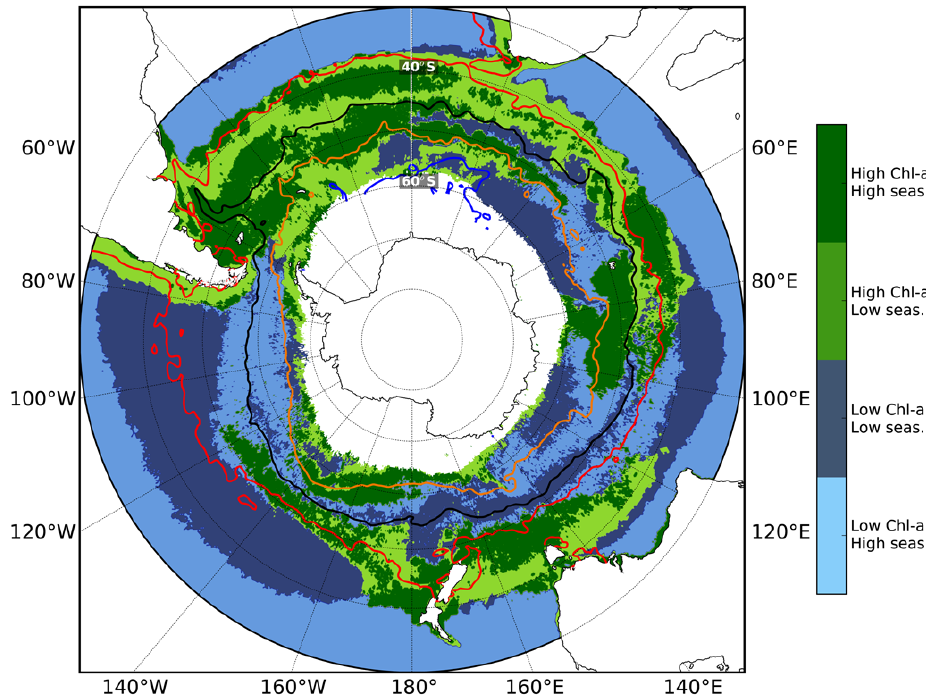
Fig. 9. A schematic summarising the response of phytoplankton biomass to the underlying physics of the different seasonal regimes. Regions in blue represent regions of low ( < 0.25mgm − 3 ) chlorophyll concentration with either high seasonal cycle reproducibility ( R 2 > 0 . 4) (Region A, light blue) or low seasonal cycle reproducibility ( R 2 < 0 . 4) (Region B, dark blue). Regions in green represent regions of high chlorophyll concentration ( > 0.25mgm − 3 ) with either high seasonal cycle reproducibility (Region C, dark green) or low seasonal cycle reproducibility (Region D, light green). Mean (1998–2007) frontal positions are shown for the STF (red), the SAF (black), the PF (yellow) and the SACCF